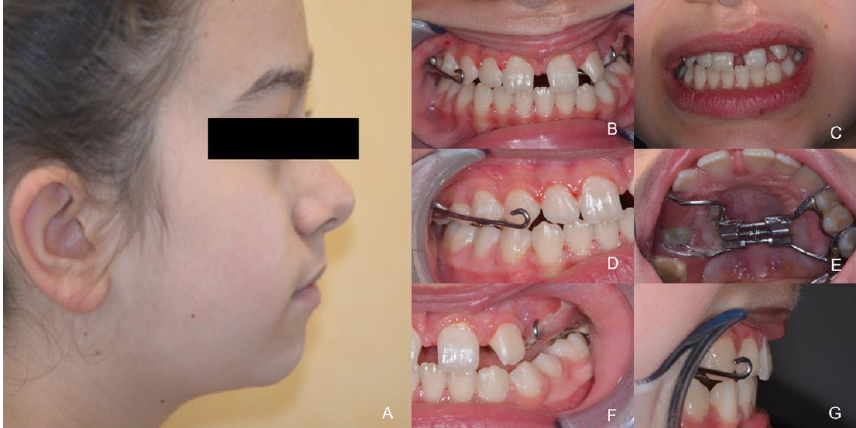
Figure 10. Result after treatment. ( A ) The profile of the patient; ( B ) Frontal intraoral view; ( C ) Frontal extraoral view; ( D ) Right lateral intraoral view; ( E ) Occlusal view; ( F ) Left lateral intraoral view; ( G ) Intraoral profile view.